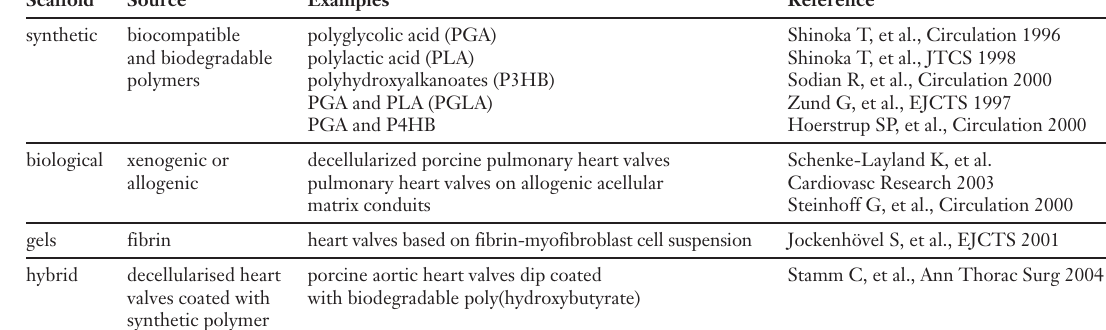
Concept of in vitro heart valve tissue engineering. Auto- logous cells are harvested from the patient and expanded in vitro (1). When sufficient numbers are reached, cells are seeded onto a biodegradable heart valve scaffold (2). Constructs are posi- tioned in a bioreactor (3) and conditioned. When tissue forma- tion is sufficient, tissue engineered heart valves are ready for implanta- tion (4).